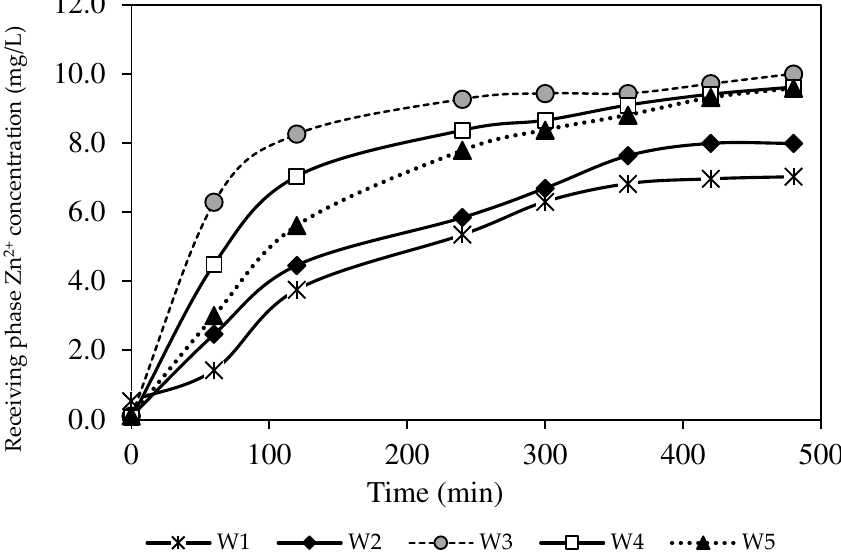
Figure 10. The Zn 2+ removal percentages of the PIM and MM-PIM samples in the receiving phase. The transported Zn 2+ recovered was less compared to the extraction process in the feeding phase. The observation was likely due to the poor dissociation rate of the ion-pair complex at the PIM-receiving interphase to remove target ions into the receiving solution. The same results were obtained from the W4 and W5 membranes that contained carbon nanotubes over 1.0%. A lower de-complexation of ion-pair formation with increased MWCNT load possibly produced denser membranes. The inferior efficiency of the PIMs without nanoparticles was proven from the con- centration of Zn 2+ absorbed in the membrane (see Figure 11). Although the W1 membrane imposed the excellent transport of Zn 2+ from the feeding phase, the amount of Zn 2+ trapped and stored in the membrane due to lower dissociation of ion-pair formation was higher than the number of target ions extracted back into the receiving phase. A similar outcome was reported by [47], where, during the filtration process, the bare membrane permitted foulants to assimilate on the membrane surface or precipitate inside the mem- brane pores. Resultantly, there was reduced membrane hydrophilicity to extract target analytes across the membrane [39,40]. Another factor was the high inclusion of nanopar- ticles that could occupy the spaces in the membrane rather than target ions, resulting in ionic exchange site blockage and an ion transport pathway shortage [23,49]. Conse- quently, the W3 membrane with 1.0% MWCNT load was chosen as the optimised MM- PIM for further studies, since it provided better extraction and back-extraction perfor- mance in transporting and removing Zn 2+ .